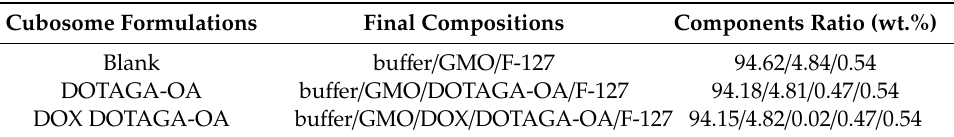
Table 1. The final compositions of the cubosome